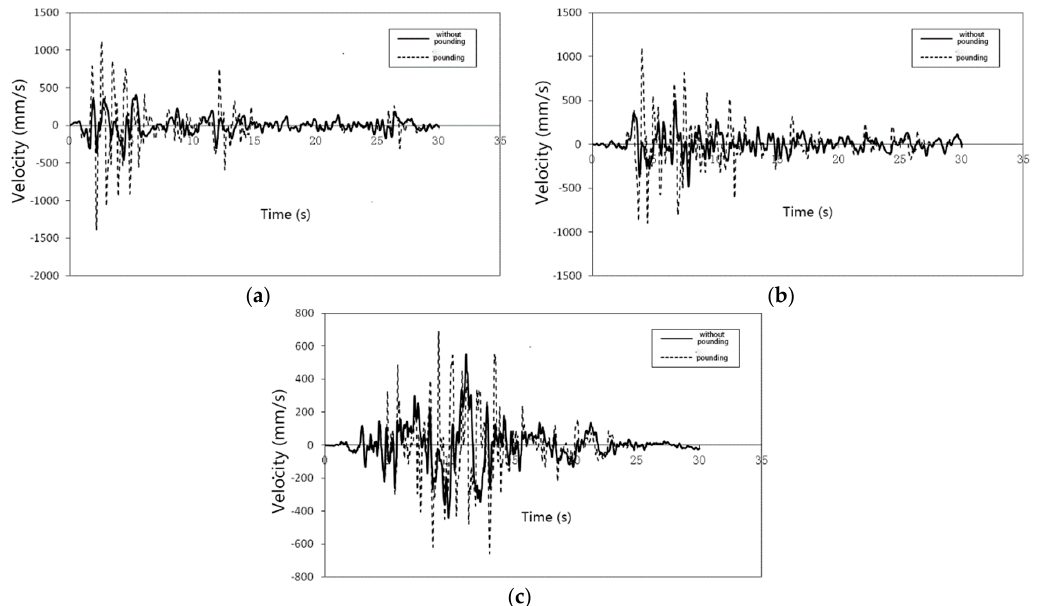
Figure 19. Structural velocity under different earthquakes (model B). ( a ) El Centro earthquakes; ( b ) Taft earthquake; and, ( c ) Artificial excitation.